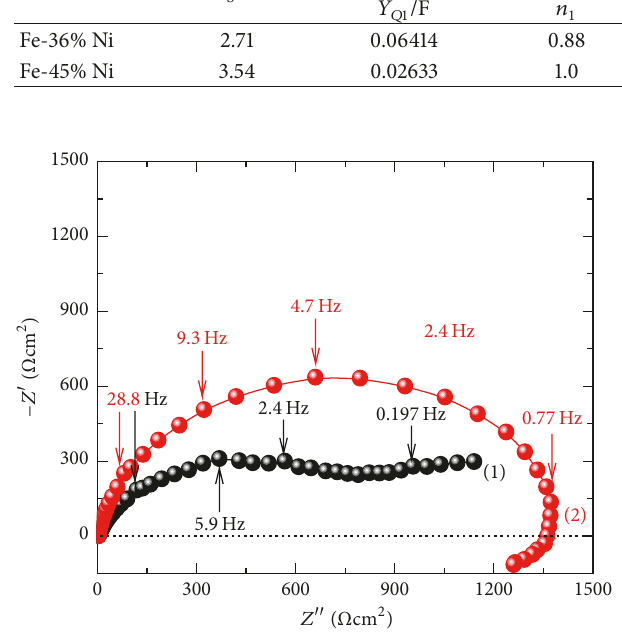
Figure 6: Nyquist plots obtained for ( 1 ) Fe-36% Ni and ( 2 ) Fe-45% Ni alloys in after their immersion for 2400 s in 1M HCl pickling solutions.